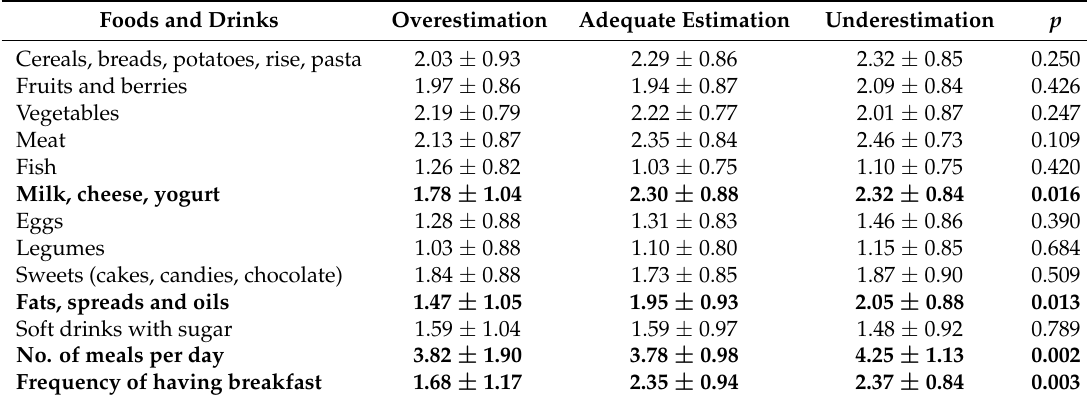
Table 6. Comparison of nutrition habits between body mass perception groups in boys (m ± SD) 1 , ( n =